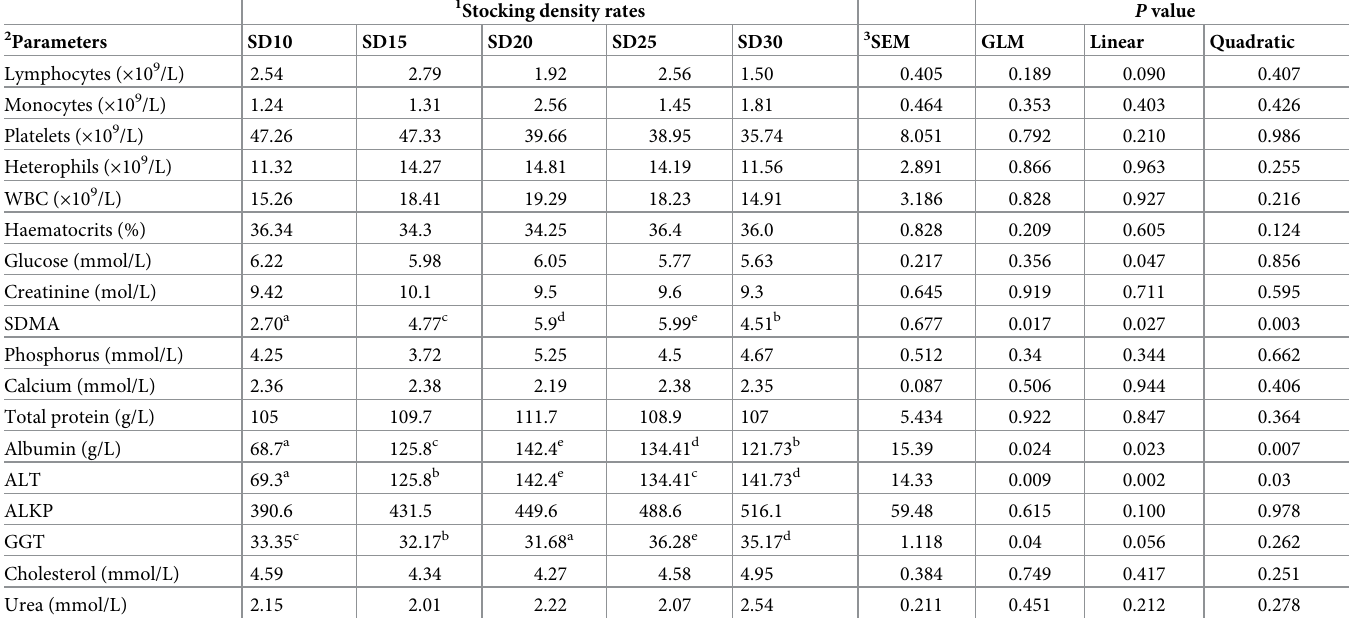
Table 3. The effects of increasing stocking density on blood parameters of Ross 308 broiler chickens. 1 Stocking density